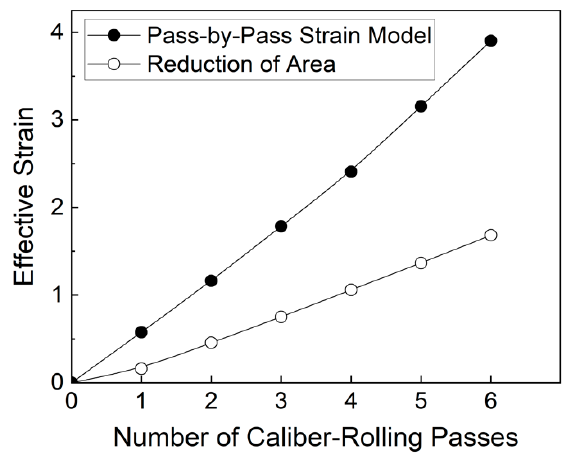
Figure 7. The effective strain of the caliber-rolled alloys calculated by the traditional approach using the reduction of area and the pass-by-pass strain model [25].